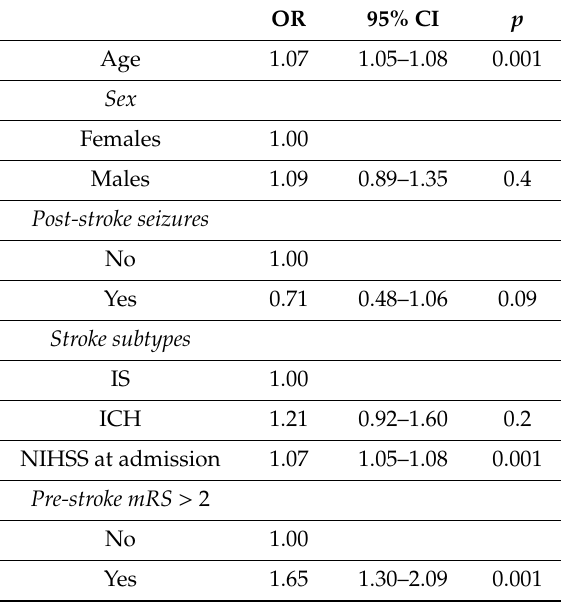
Figure 2. Survival curves for all-cause mortality according to post-stroke seizures. Table 3. Cox analysis, predictors of all-cause long-term mortality.